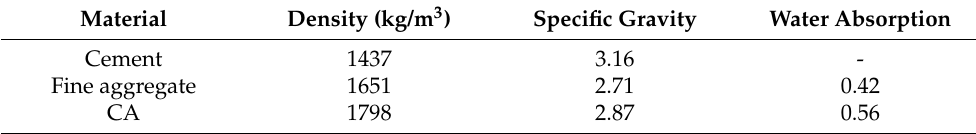
Table 1. Physical properties of